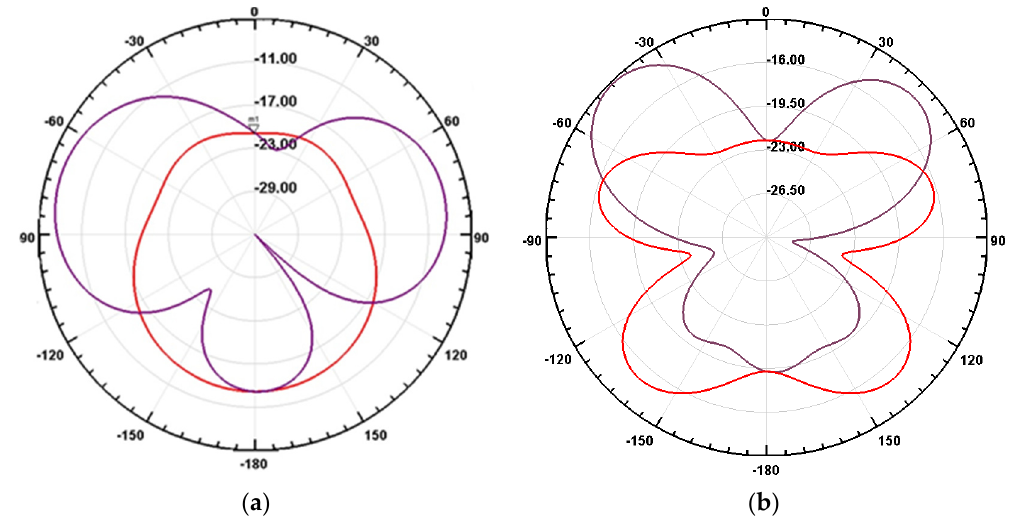
Figure 5. Radiation pattern of antenna operating at 0.5 GHz ( a ) and 1.3 GHz ( b ). (Red pattern: H-plane and purple pattern: E plane).